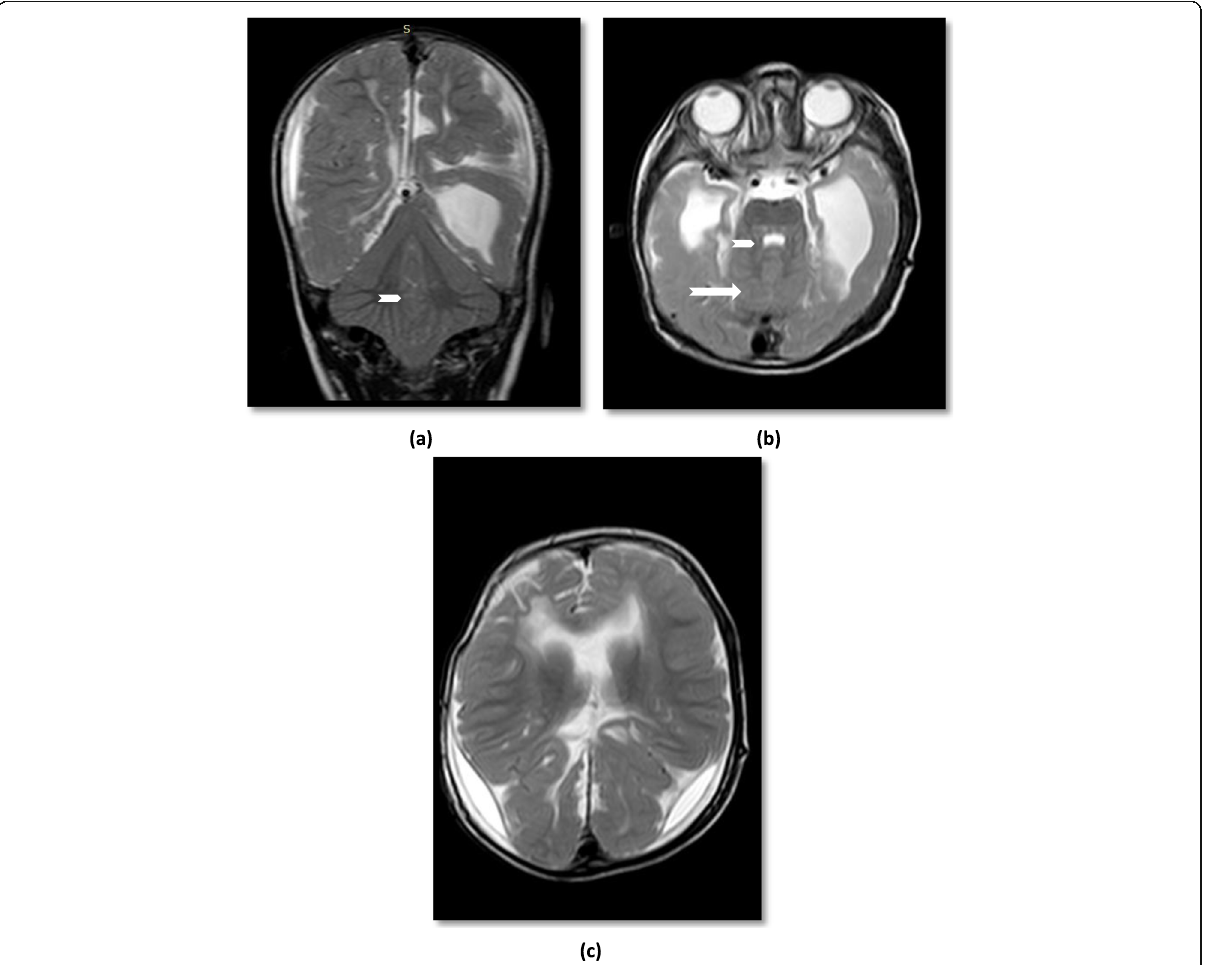
Fig. 3 A 2.5-year-old boy who presented with ataxia. a Posterior coronal T2-weighted MR image shows continuity of the cerebellar hemispheres with an abnormal transverse orientation of the cerebellar foliae (arrowheads). b , c Axial T2-weighted MR image shows continuity of the cerebellar hemispheres, dentate nuclei (arrows), and superior cerebellar peduncles without an intervening vermis, key hole appearance of the fourth ventricle (arrowheads), associated with aqueductal stenosis and supratentorial abnormalities (supratentorial hydrocephalus, absent septum pellucidum, callosal dysgenesis, abnormal gyration, and also bilateral subdural hematoma). Final diagnosis: